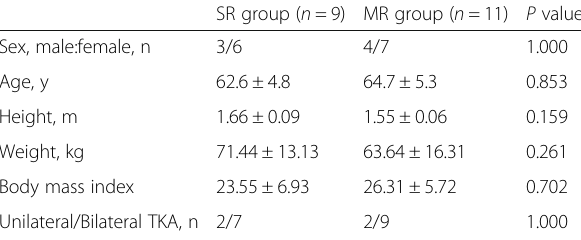
Table 1 Demographic and clinical data (mean ± SD) of included